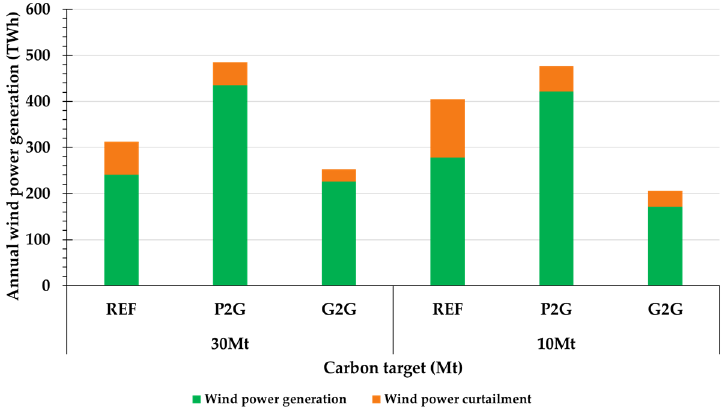
Figure 9. The wind power capacity and its load factor under different carbon targets.